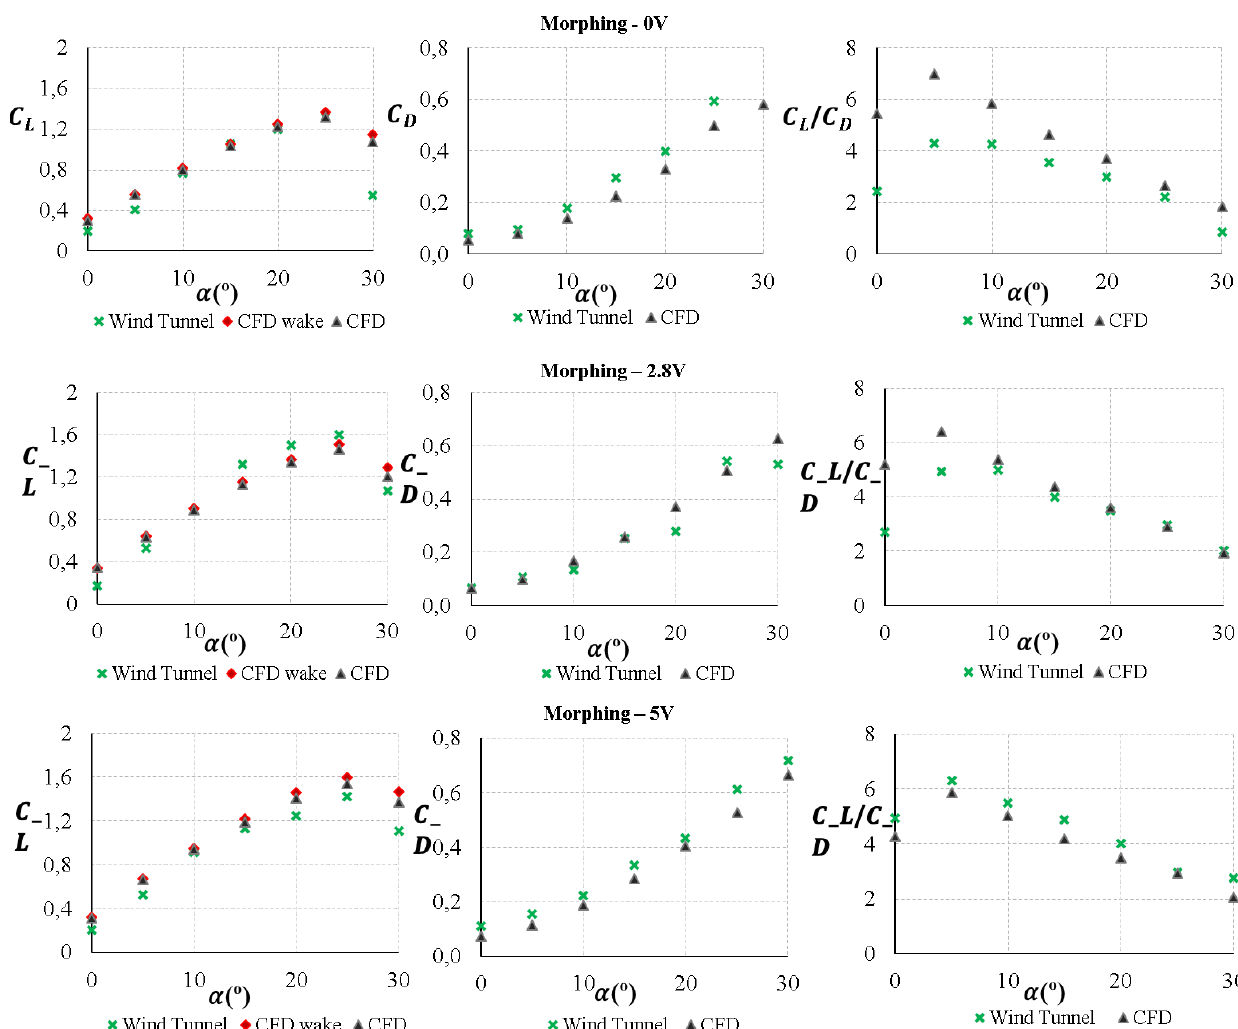
Figure 15. Control volume and wake volume meshed ( left ) and unstructured mesh of the MAV ( right ). ( U ∞ = 10 m/s, α = β = 0 ◦